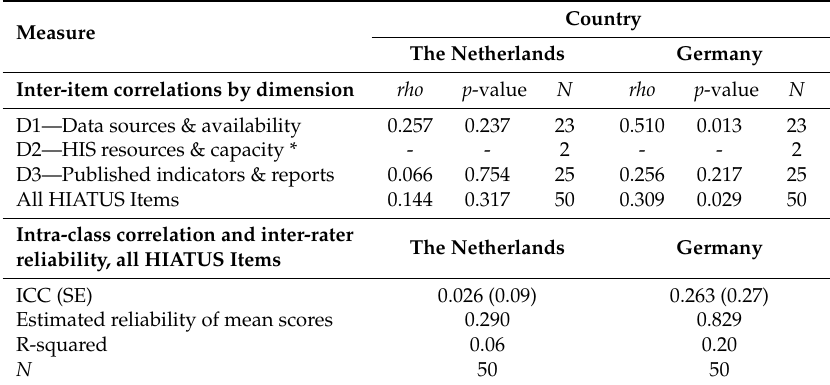
Table 2. Inter-item correlations, intra-class correlation and inter-rater reliability.